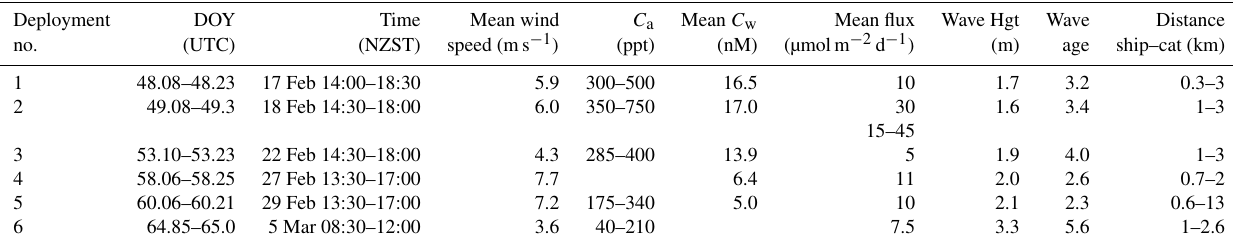
Figure 3. Background environmental parameters. (a) Wind speed adjusted to 10m height ( U 10 ). (b) Sensible and latent heat fluxes derived from COARE3.5. (c) Stability parameter z/L , with negative denoting unstable conditions: zero, neutral stability; positive, stable conditions. (d) Significant wave height from WAVEWATCH III. (e) Wave age (Cp /U 10 ) , with 1.2 denoting full development. Spar buoy deployments are denoted by the red horizonal bars, and catamaran GF deployments by the * symbol in the top panel. Table 1. Summary of environmental conditions and DMS concentrations in air ( C a ) and water ( C w ) during gradient flux